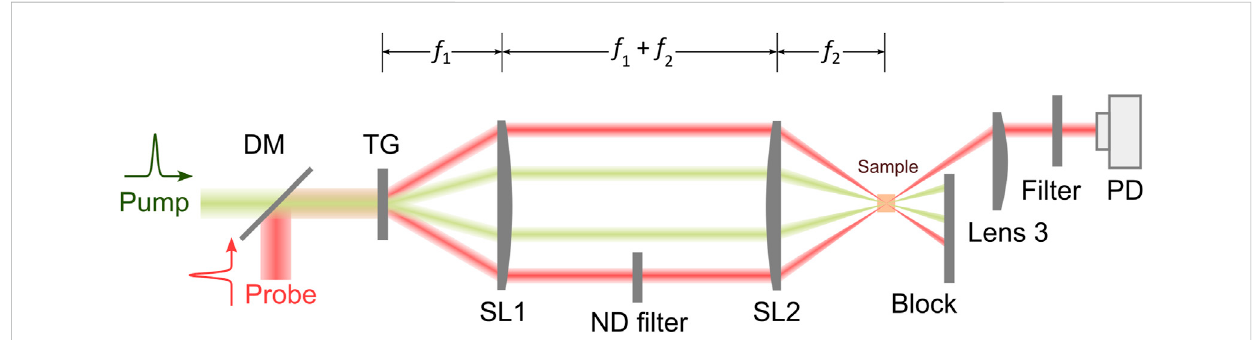
FIGURE 4 Schematic of a representative ISBM setup. DM: dichroic mirror; TG: transmission grating; PD: photodetector. f 1 , f 2 : focal length of Lenses SL1 and SL2, respectively.